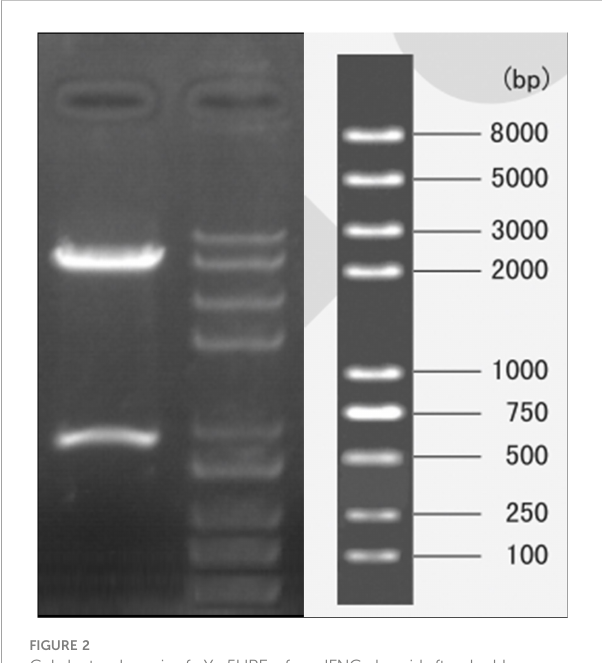
FIGURE 2 GelelectrophoresisofpYr-5HRE-cfosp-IFNGplasmidafterdouble